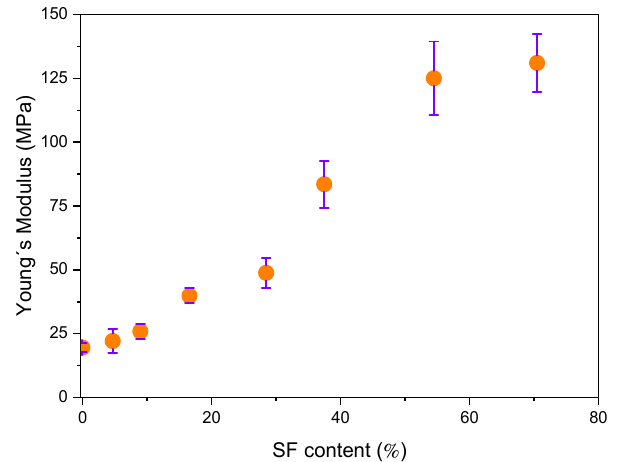
Figure 4. Changes of Young´s modulus for r-PET electrospun mats as a function of content SF was varying from 0 to 70.5 V/V % (from r-PET to r-PSF7).